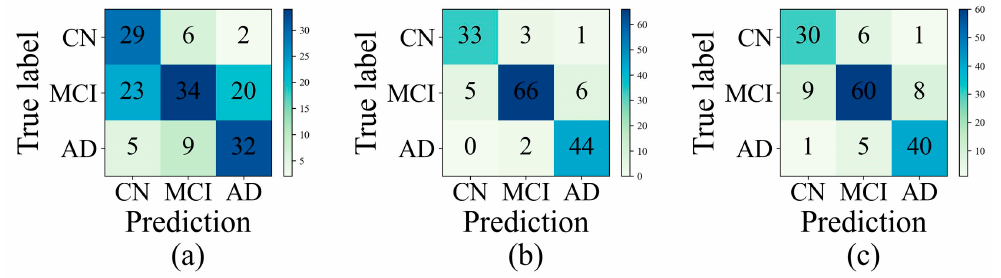
Figure 4. Confusion matrices of three-group (AD, MCI, and CN) classification on the test data: ( a ) the default graph with S img as the edge-assigning function; ( b ) the graphs with S nimg as the edge-assigning function; and ( c ) the graphs with S com as the edge-assigning function.